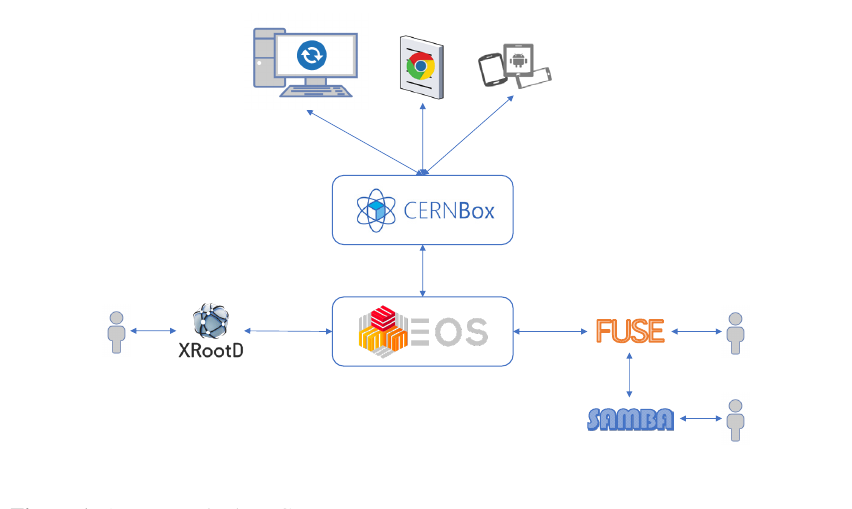
Figure 1. Access methods to